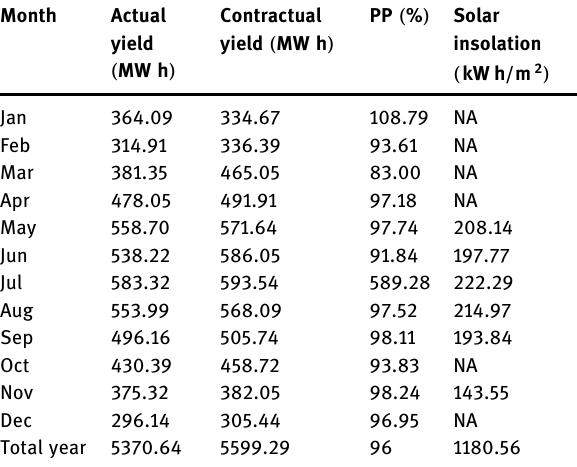
Table 5: Monthly actual yield, contractual yield, PR and solar insolation for Yarmouk University PV solar power plant during